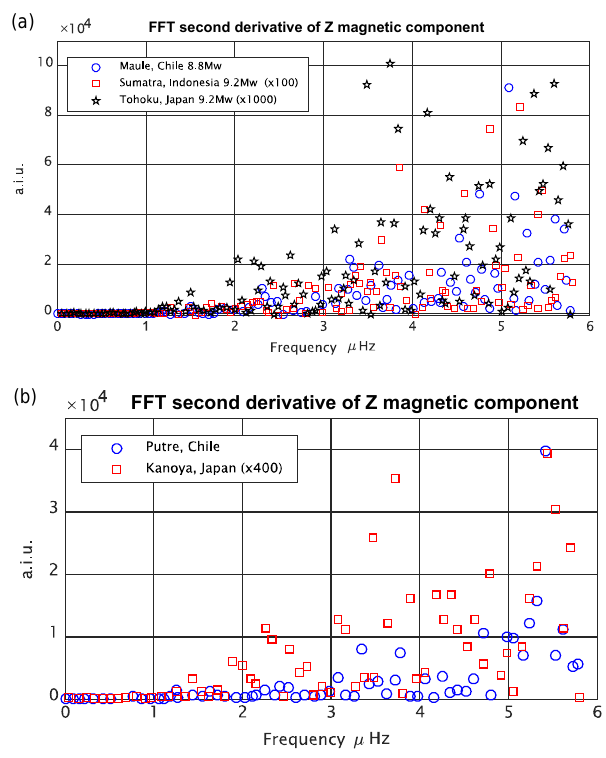
Figure 5. Fourier analysis of second derivative of Bz component, where the frequencies are on the order of microhertz. In (a) we show the significant frequencies for the earthquakes in Maule, To- hoku and Sumatra; panel (b) shows the significant frequencies for earthquake of Tohoku, recorded in Putre, Chile, and Kanoya, Japan, respectively. Both panels show the rising of a frequency band inside the 5.680 and 3.510µHz